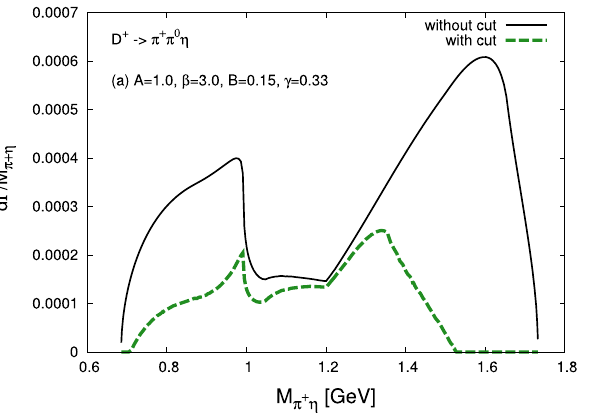
Fig. 11 Results for D + → π + π 0 η with and without the cut M inv (π + π 0 ) > 1 GeV for the set A = 1, β = 3, B = 0 . 15, γ = 0 . 33